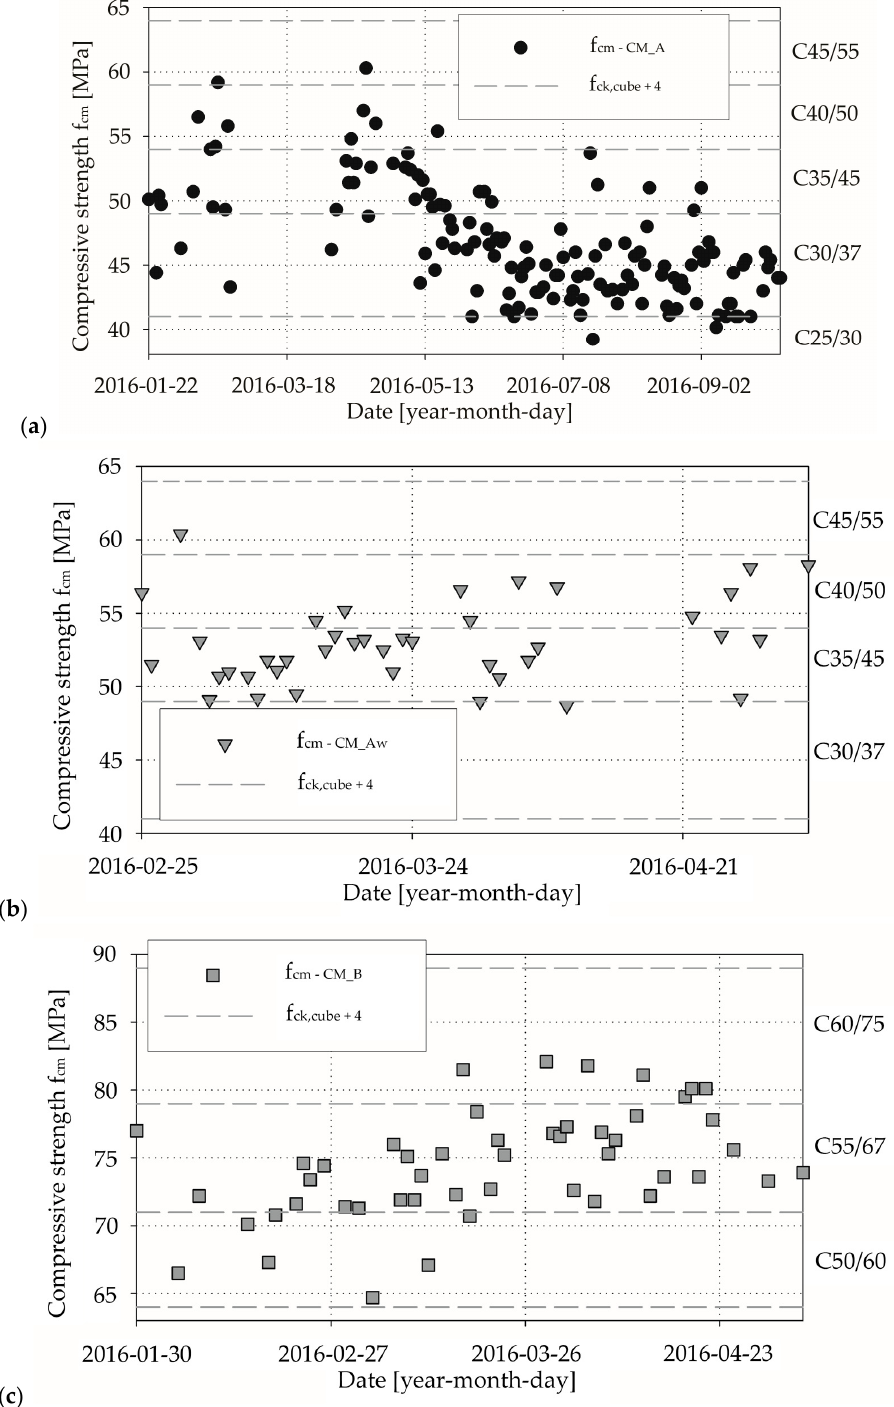
Figure 5. Criterion 1 for compressive strength classes conditions: ( a ) CM_A mix; ( b ) CM_Aw mix; ( c ) CM_B mix.